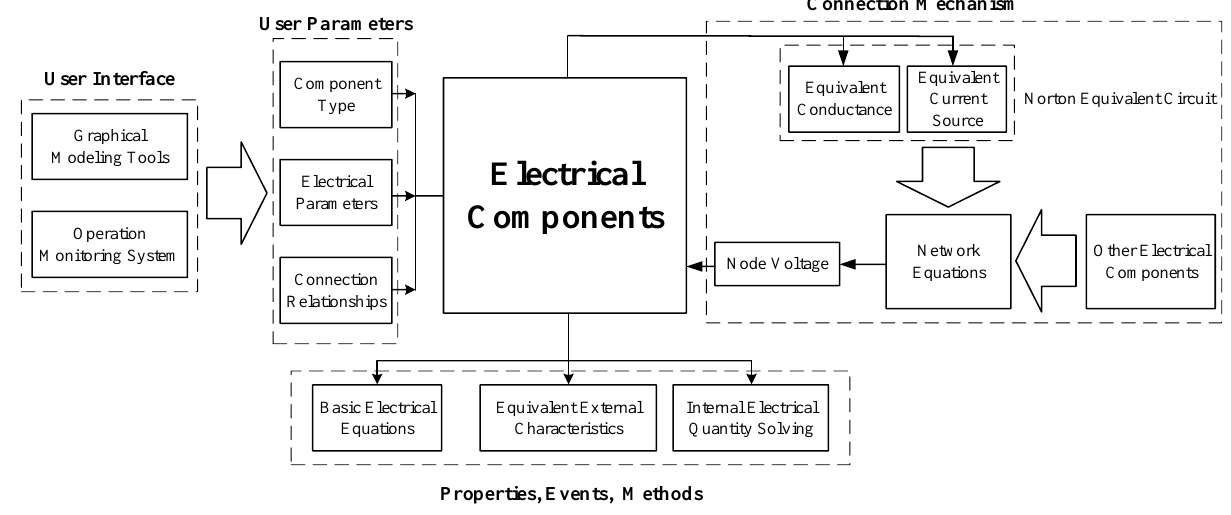
Figure 3. Schematic diagram of electrical components.